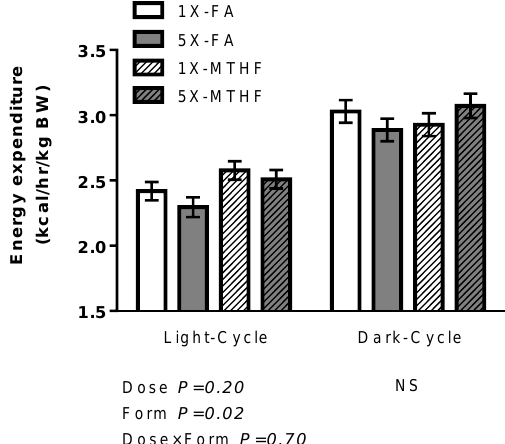
Figure 2. Average energy expenditure (kcal/kg/h) during 24 h in dams at 15-weeks post-weaning (PW). Embedded graph represents the effect of Form alone (FA vs. MTHF). n = 10–12/group. Values are Least Square Mean ± S.E.M. Analyzed by Two-way ANOVA, significance at p < 0.05. Abbreviations: AIN-93G rodent diet with 1X (recommended, 2 mg/kg) or 5X folic acid (FA) or equimolar [6 S ]-5-methyltetrahydrofolic acid calcium salt (MTHF) at 1X (2.1 mg/kg) or 5X (10.4 mg/kg)